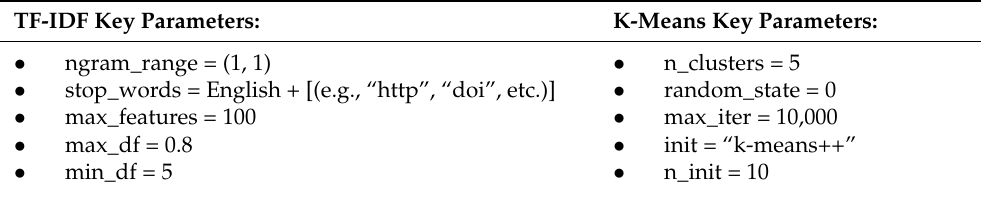
Table 2: Table 2. Analysis key parameters used for TF-IDF and K-means text Table 2. Analysis key parameters used for TF-IDF and K-means text clustering.